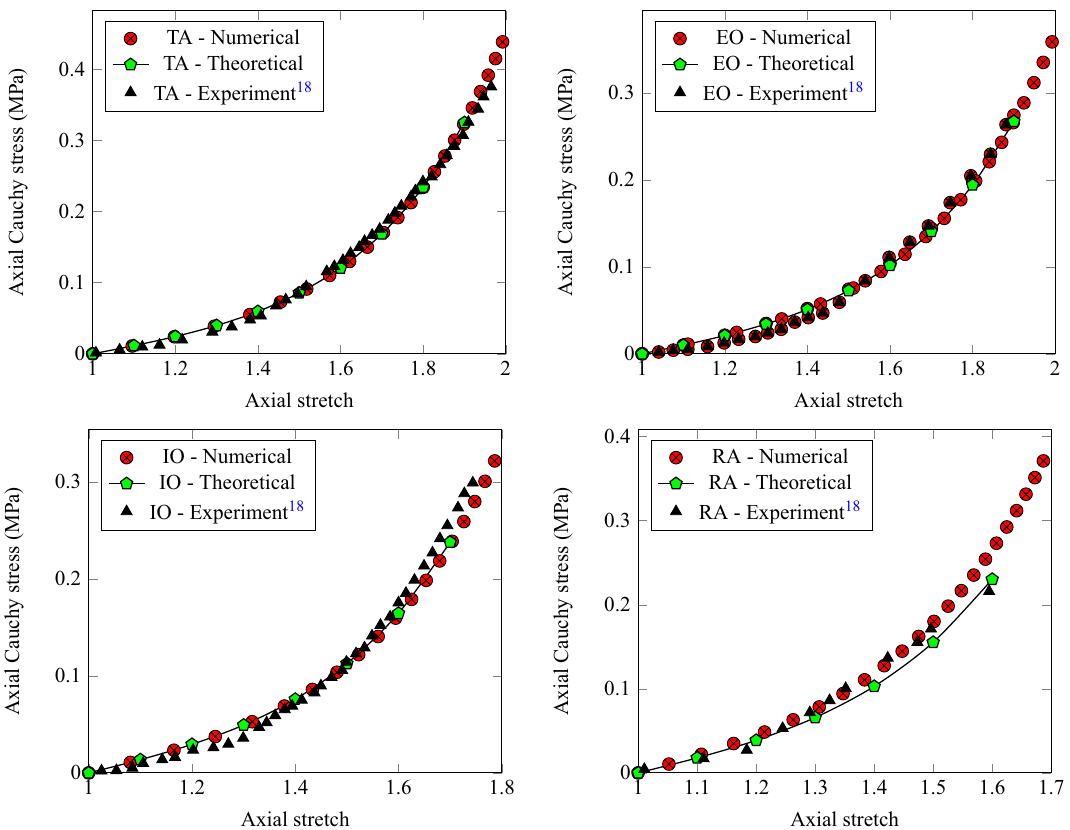
Figure 3. Calibration and validation of the model using the uniaxial experimental data of Cardoso conducted on specimens from abdomen muscles 18